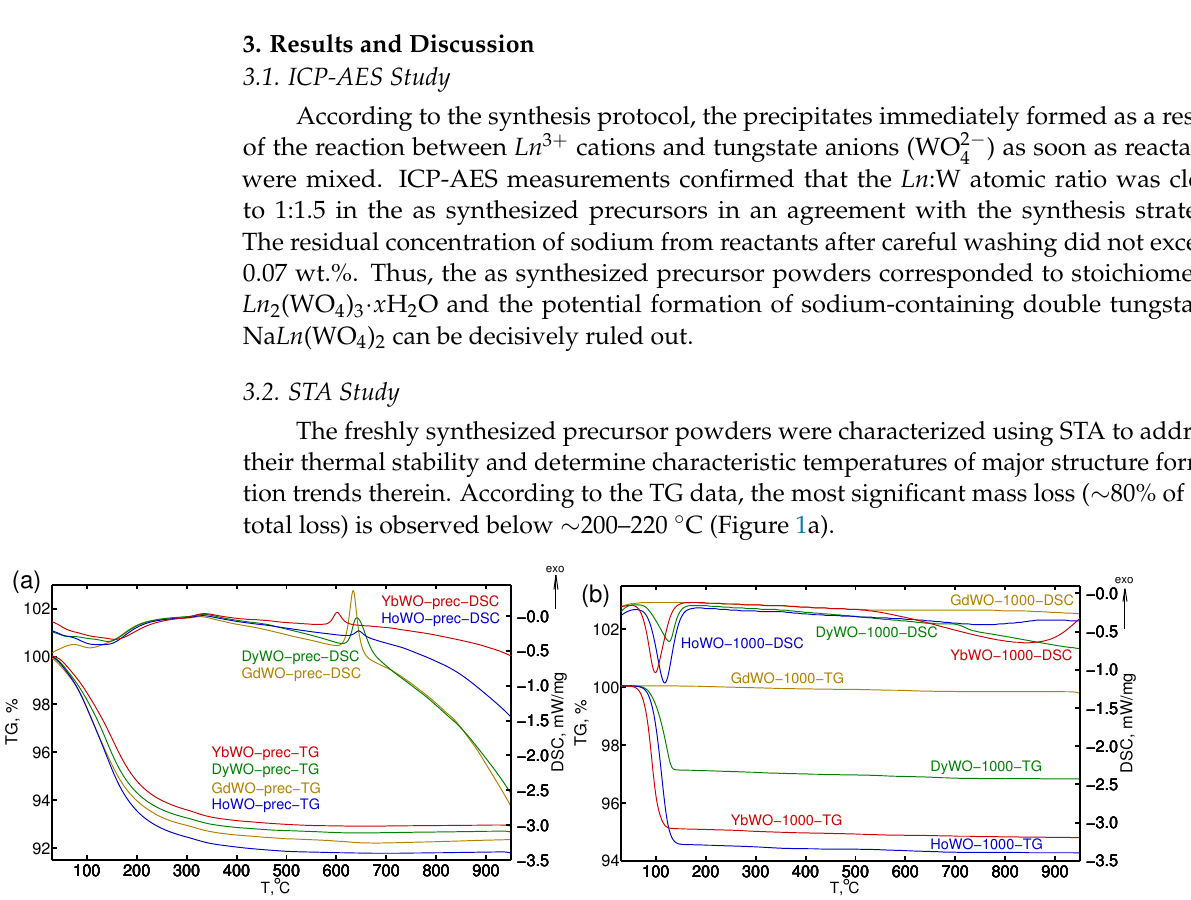
Figure 1. STA curves for Ln tungstates precursors Ln WO-prec ( a ) and Ln WO-1000-1.5y ( Ln = Gd, Dy, Ho, Yb) powders ( b